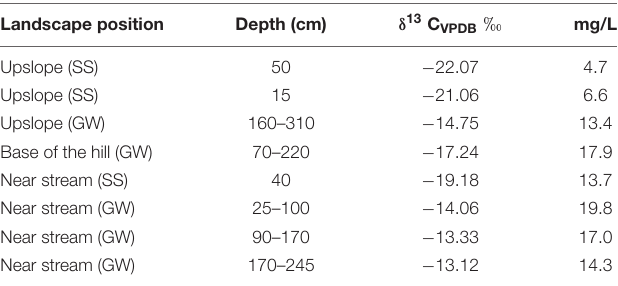
TABLE 3 | δ C 13 of dissolved organic carbon and concentrations in soil solution (SS) and groundwater (GW) at different landscape positions and depths. Landscape position